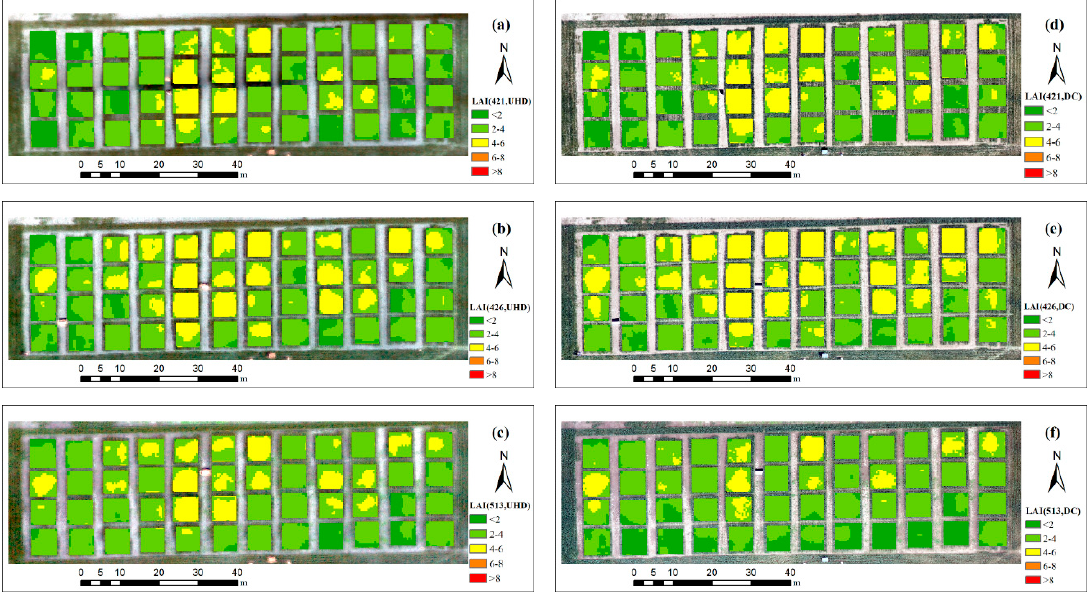
Figure 11. Leaf Area Index (m 2 /m 2 ) maps based on UAV-UHD and UAV-DC images and with PLSR. ( a ) UHD on 21 April; ( b ) UHD on 26 April; ( c ) UHD on 13 May; ( d ) DC on 21 April; ( e ) DC on 26 April; ( f ) DC on 13 May. Note: UHD- indicates data measured using the snapshot hyperspectral sensor mounted on the UAV; and DC- indicates data measured by using the digital camera mounted on the UAV.